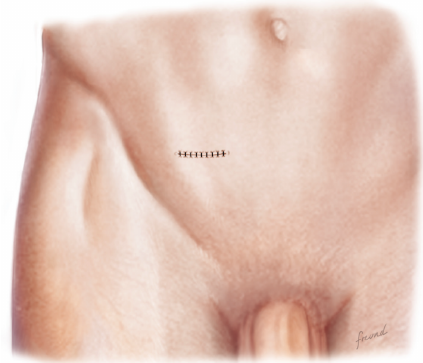
Figure 14: The external fascia is closed with sutures and the skin is closed with sutures or